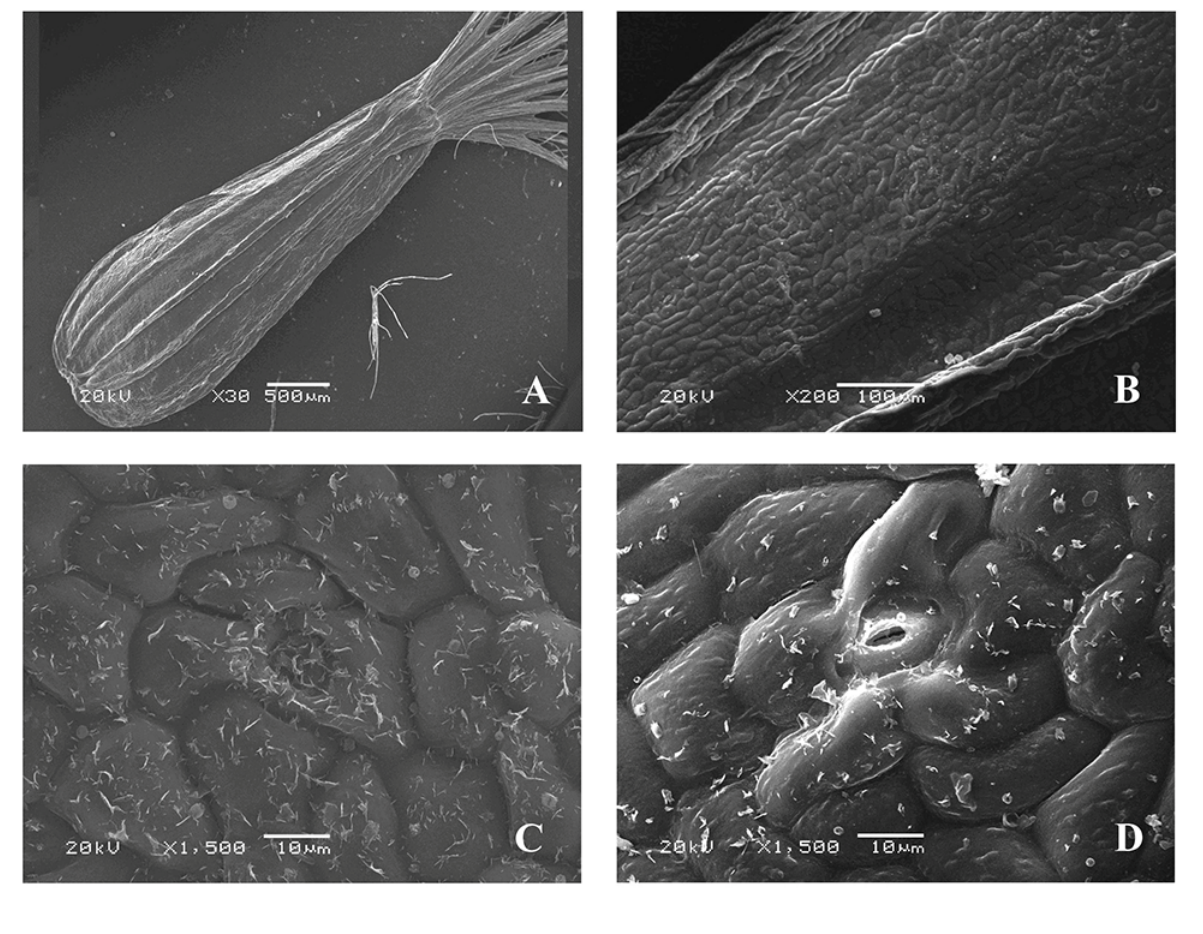
Figure 2 Fruit of Valeriana tripteris (SEM): General view ( A ); fragment of the fruit surface ( B ); stomium ( C,D